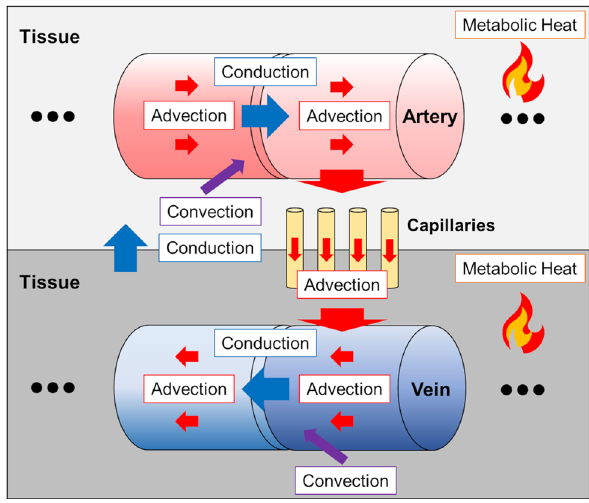
Fig. 1 Heat transfer modes and domains used to model brain temperature. Metabolically generated thermal energy is transported between the tissues, arteries, and veins by three heat transfer modes: conduction, advection (transport of thermal energy by a moving fl uid), and convection (heat transfer from a fl owing fl uid to a wall resulting from combined effects of local conduction and advection represented by the local heat transfer coef fi cient). Energy and mass are conserved within each domain locally and globally across the whole brain and described by a system of equations (see “ Methods ” section). Red arrows represent the direction of blood fl ow and subsequent advection. Blue arrows represent conductive heat transfer from higher to lower temperature regions. Purple arrows that cross a vessel segment and intersected voxel represent the presence of convective heat transfer. The shaded (or darker) vessel segment or tissue voxel represents a higher temperature than the unshaded (or brighter) vessel segment or tissue voxel.